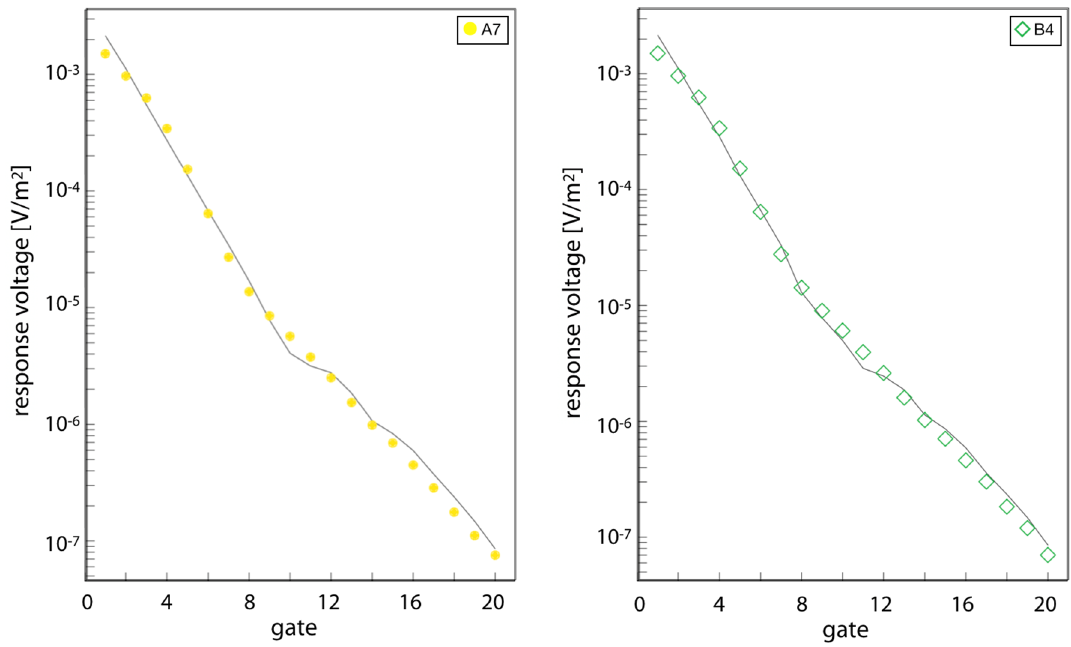
Figure 11. 2D modeling results of station A7 and B4 from left to right. A computed step ‐ off voltage from 3D forward modeling code at cross ‐ section point of two transects is shown as a black line.